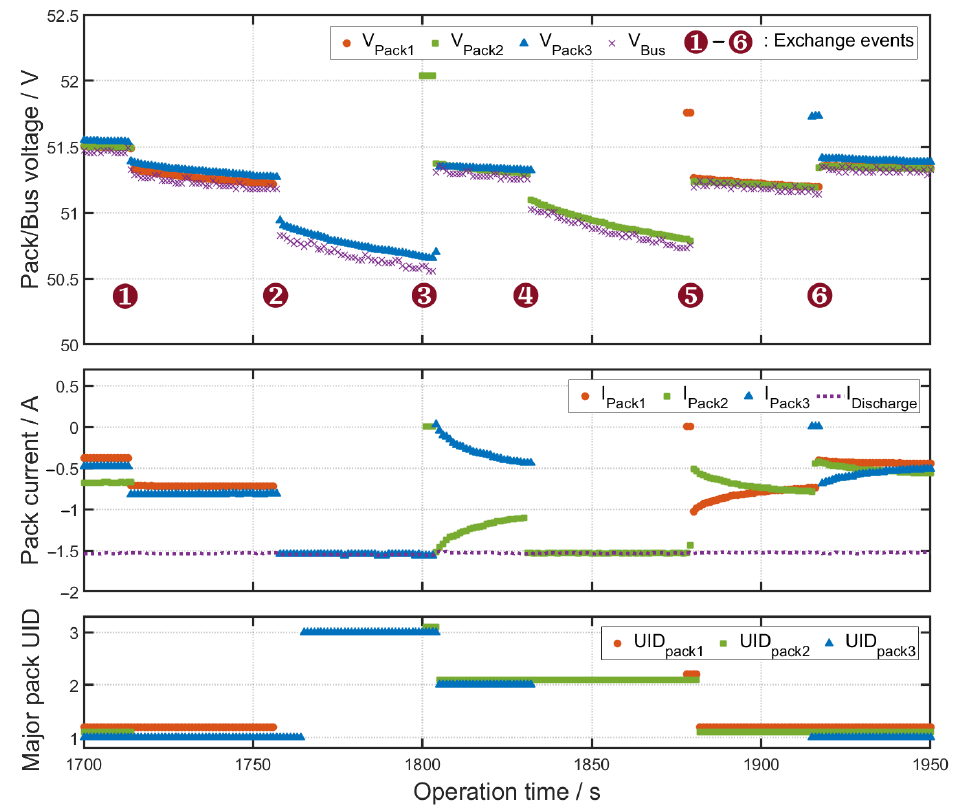
Figure 13. Enlarged view of battery pack insertion/removal events during discharging.